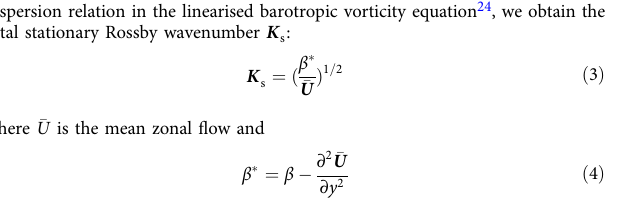
where (cid:1) U ¼ ð (cid:1) u ; (cid:1) v Þ is the basic wind fi eld; ψ ′ is the streamfunction anomaly derived from geopotential height through the use of quasigeostrophic approximation. The regression pattern of W shown in Fig. 3d, f are calculated using the regressed